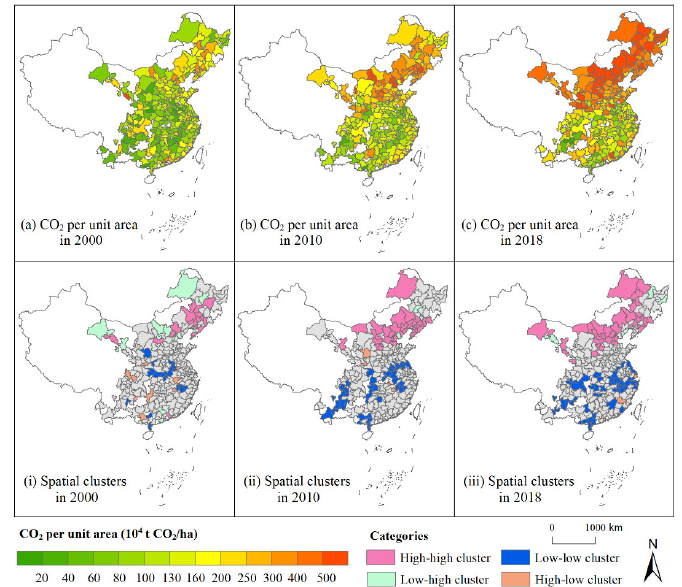
Figure 3. Spatial distribution and clusters of CO 2 per unit area in the years 2001, 2010, and 2018. (( a – c ) represents the spatial distributions of CO 2 per unit area in 2000, 2010 and 2018, respectively; ( i – iii ) denotes the spatial clusters of CO 2 per unit area in 2000, 2010 and 2018, respectively)